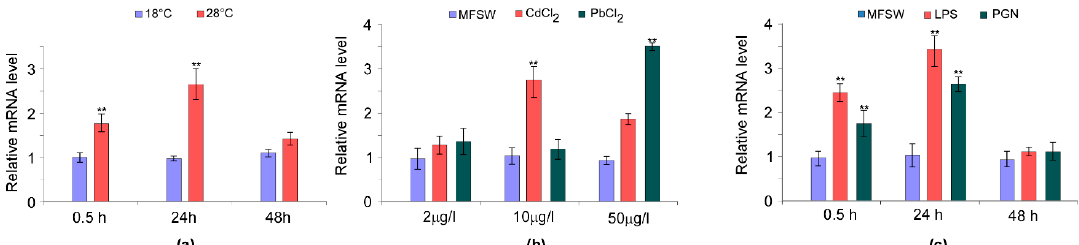
Figure 8. Expression profiles of AvTCTP in response to physical and biotic challenges. ( a ) Sea anemones were challenged by hyperthermic conditions at 28 °C, while animals maintained at 18 °C were used as controls. The tentacles were sampled at different time points post-challenge (0.5 h, 24 h and 48 h). ( b ) Sea anemones were exposed to Pb and Cd at different concentrations for 12 h, while animals maintained in MFSW were used as controls. ( c ) Sea anemones were stimulated with different immunogens, while HBSS injected animals were used as controls. Portions of basal disk were sampled from different animals at different time post-challenge (0.5 h, 24 h and 48 h). The expression level of AvTCTP was analysed by qRT-PCR with RCC2 and COP- γ as references. The results are represented as means ± standard deviation (SD) ( n = 3). Statistical analysis by one-way ANOVA with Tukey’s post-test. ** correspond to p <